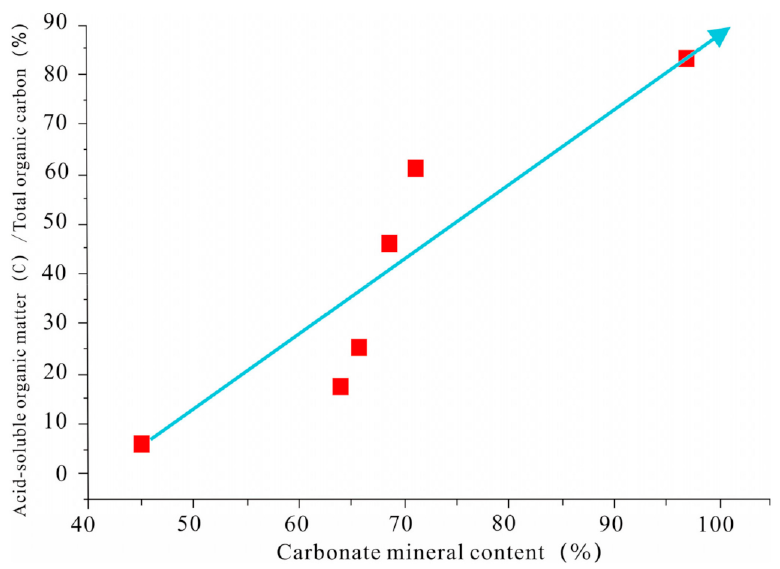
Figure 6. Relationship between carbonate mineral content and TOC loss rate in Eagle Ford